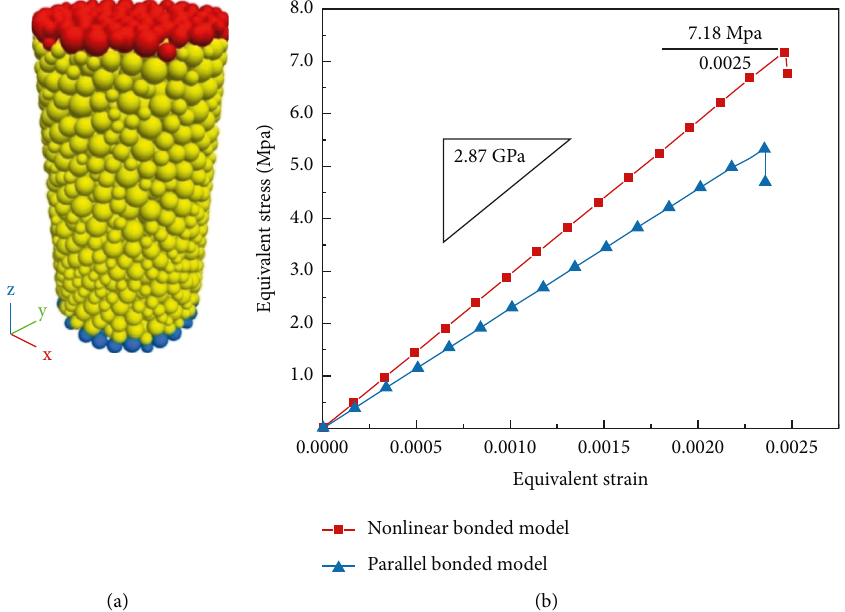
Figure 2: Simulation of direct tensile test: (a) the loading diagram and (b) the equivalent stress-equivalent strain curve.